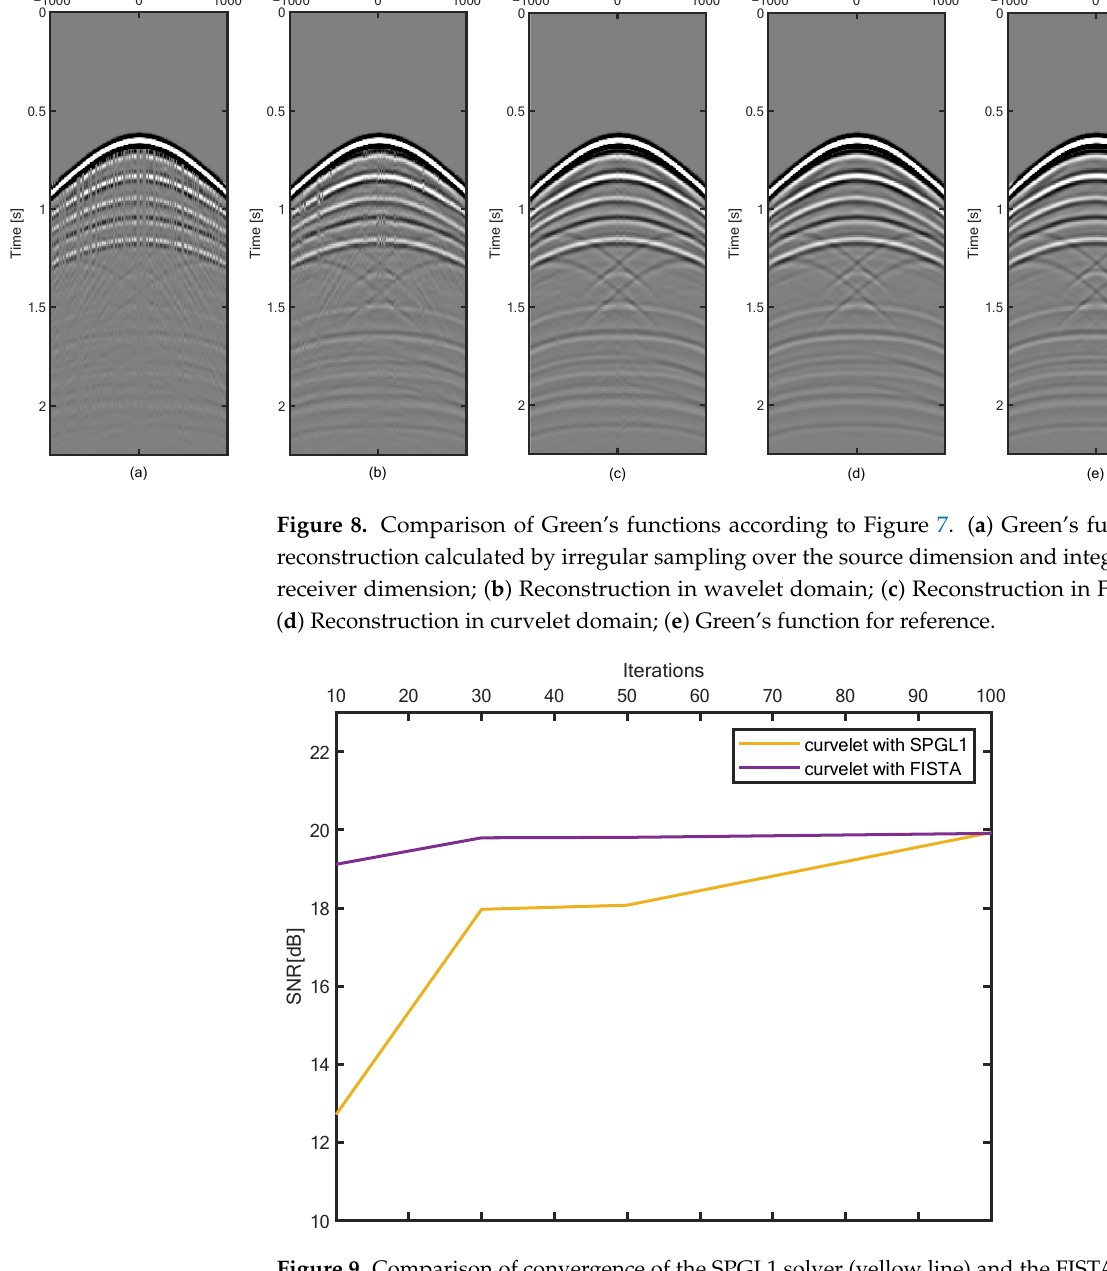
Figure 9. Comparison of convergence of the SPGL1 solver (yellow line) and the FISTA solver (purple line) in curvelet transform for focusing function reconstruction.